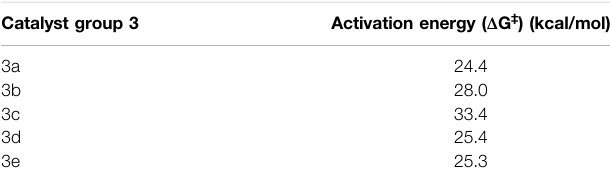
TABLE 3 | The catalytic performance of Group 3 catalyst, 3a – 3e . Catalyst group